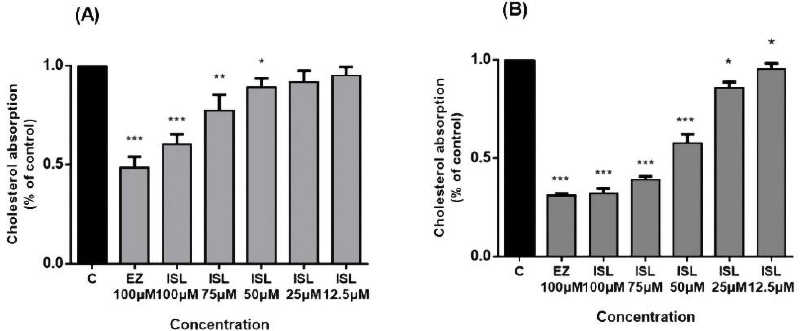
Figure 4. Inhibitory effect of ISL on cholesterol uptake in HepG2/Caco-2 cells. Cells were pretreated with different concentrations of ISL for 4 h and then incubated with radioactive micellar cholesterol for 1 h. In the absence of ISL, cholesterol uptake was normalized to 100%. Results are the mean ± SEM of three determinations in three independent experiments. ( A ) Inhibitory effect of ISL on cholesterol uptake in HepG2 cells. ( B ) Inhibitory effect of ISL on cholesterol uptake in Caco-2 cells. * p < 0.05, ** p < 0.001, *** p < 0.0001.